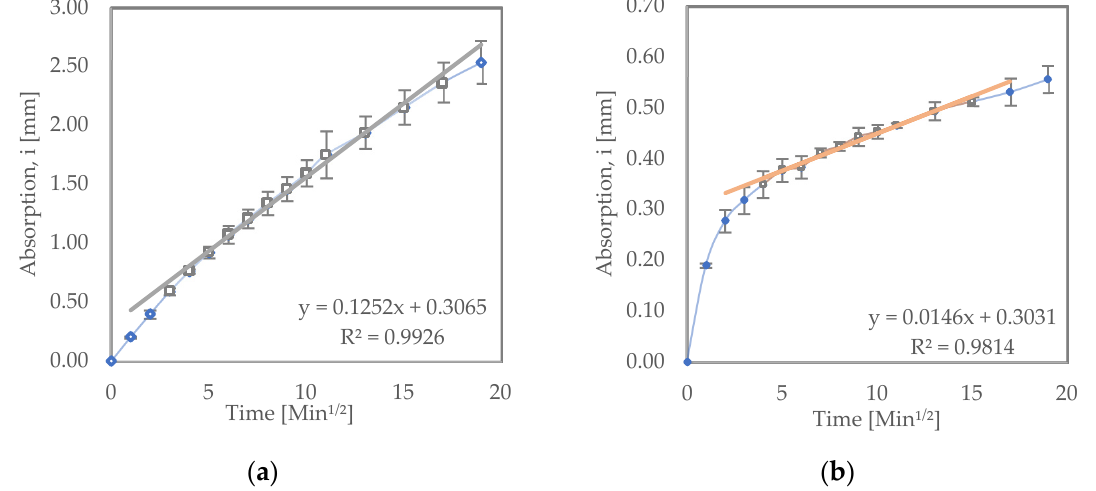
Figure 3. Sorptivity results for ( a ) OPC and ( b ) LC 3 samples recurred in water.